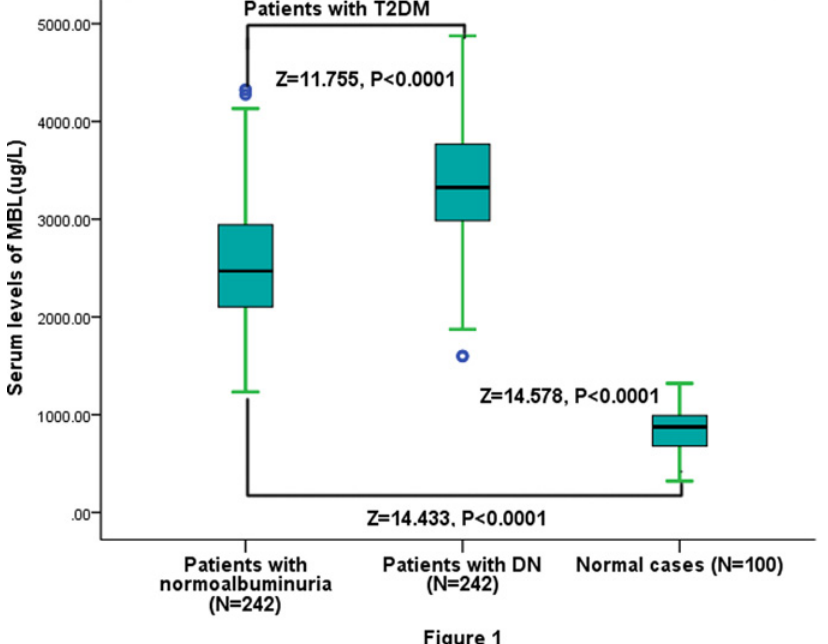
Fig 1. Distribution of serum MBL levels in diabetic patients with diabetic nephropathy (DN) and with persistent normoalbuminuria and normal controls. All data are medians and in-terquartile ranges (IQR). P values refer to Mann-Whitney U tests for differences between